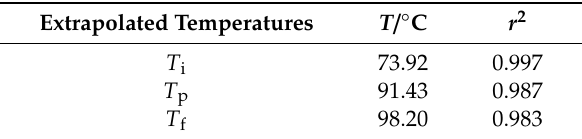
Figure 4. The fitting curves of characteristic temperatures for AG-80 / m-XDA curing system ( phr = 26) with different heating rates . Table 4. Extrapolation values of the characteristic temperatures for AG-80 / m-XDA curing system ( phr = 26) with different heating rates .